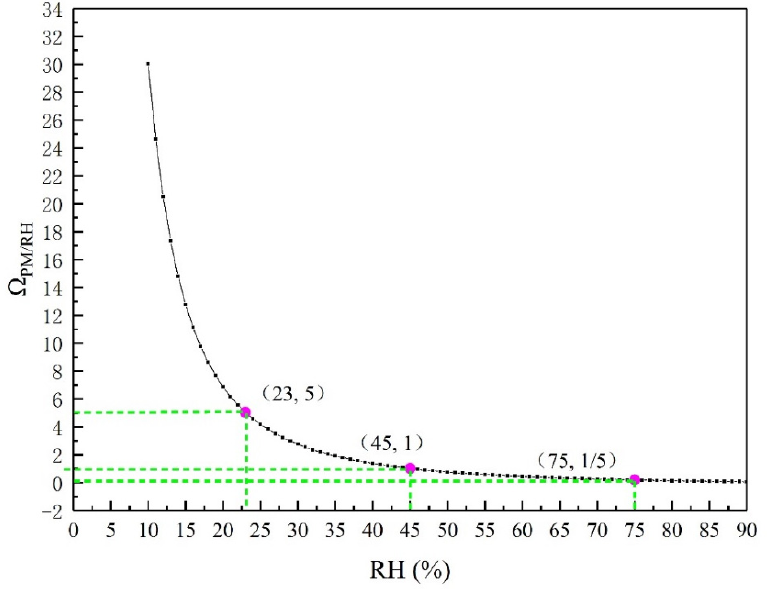
Figure 3. Variation characteristics of the visibility relative sensitivity index ( Ω PM/RH ) in Tianjin, 2015 (abscissa is RH, 10–90%; the ordinate is relative sensitivity index). The values of 0.6, 1, 5, 10, and 15 km of visibility are the key points that refer to the